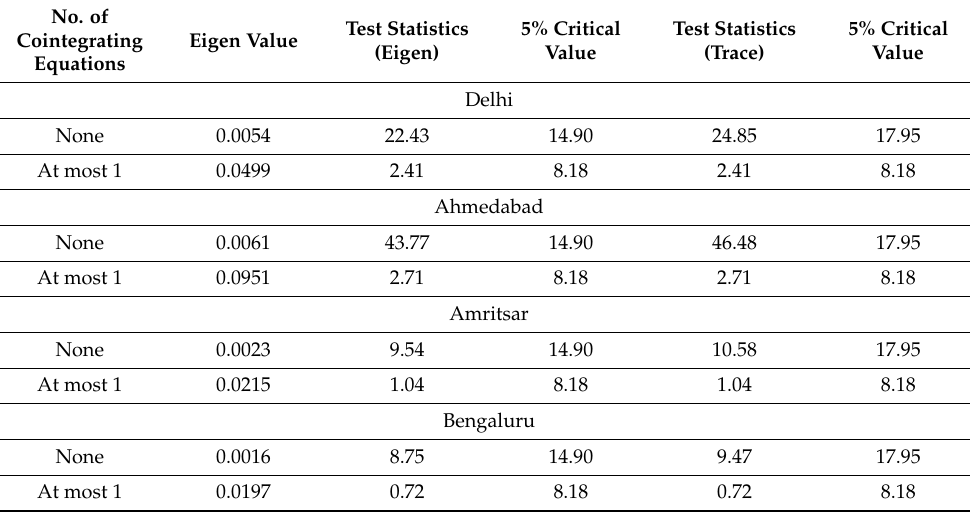
Table 4. Market-wise cointegration between the wholesale and retail prices of